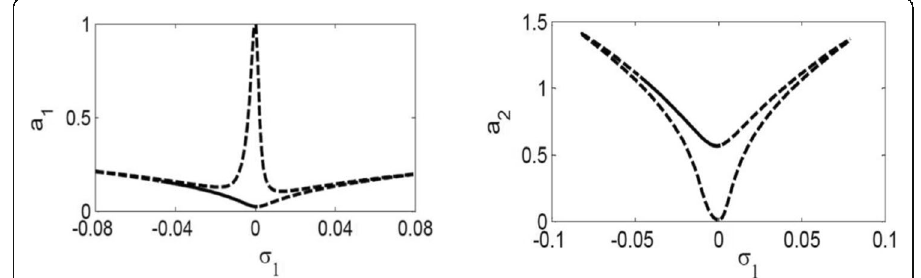
Fig. 3 Effects of the detuning parameter σ 1 for μ 1 = 0.001, μ 2 = 0.00098, f 1 = 0.01, f 2 = 0.05, α 1 = 0.002, α 2 = 0.002, ω 1 = 4, δ = 0.0001, β = 1, γ =